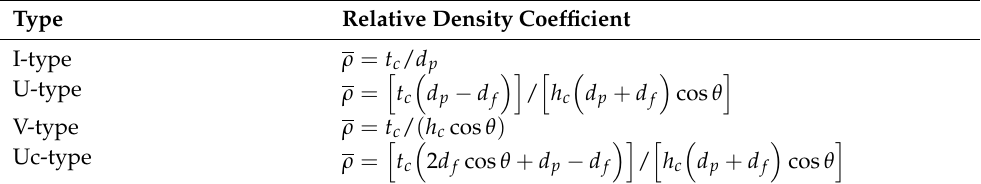
Table 1. Relative density